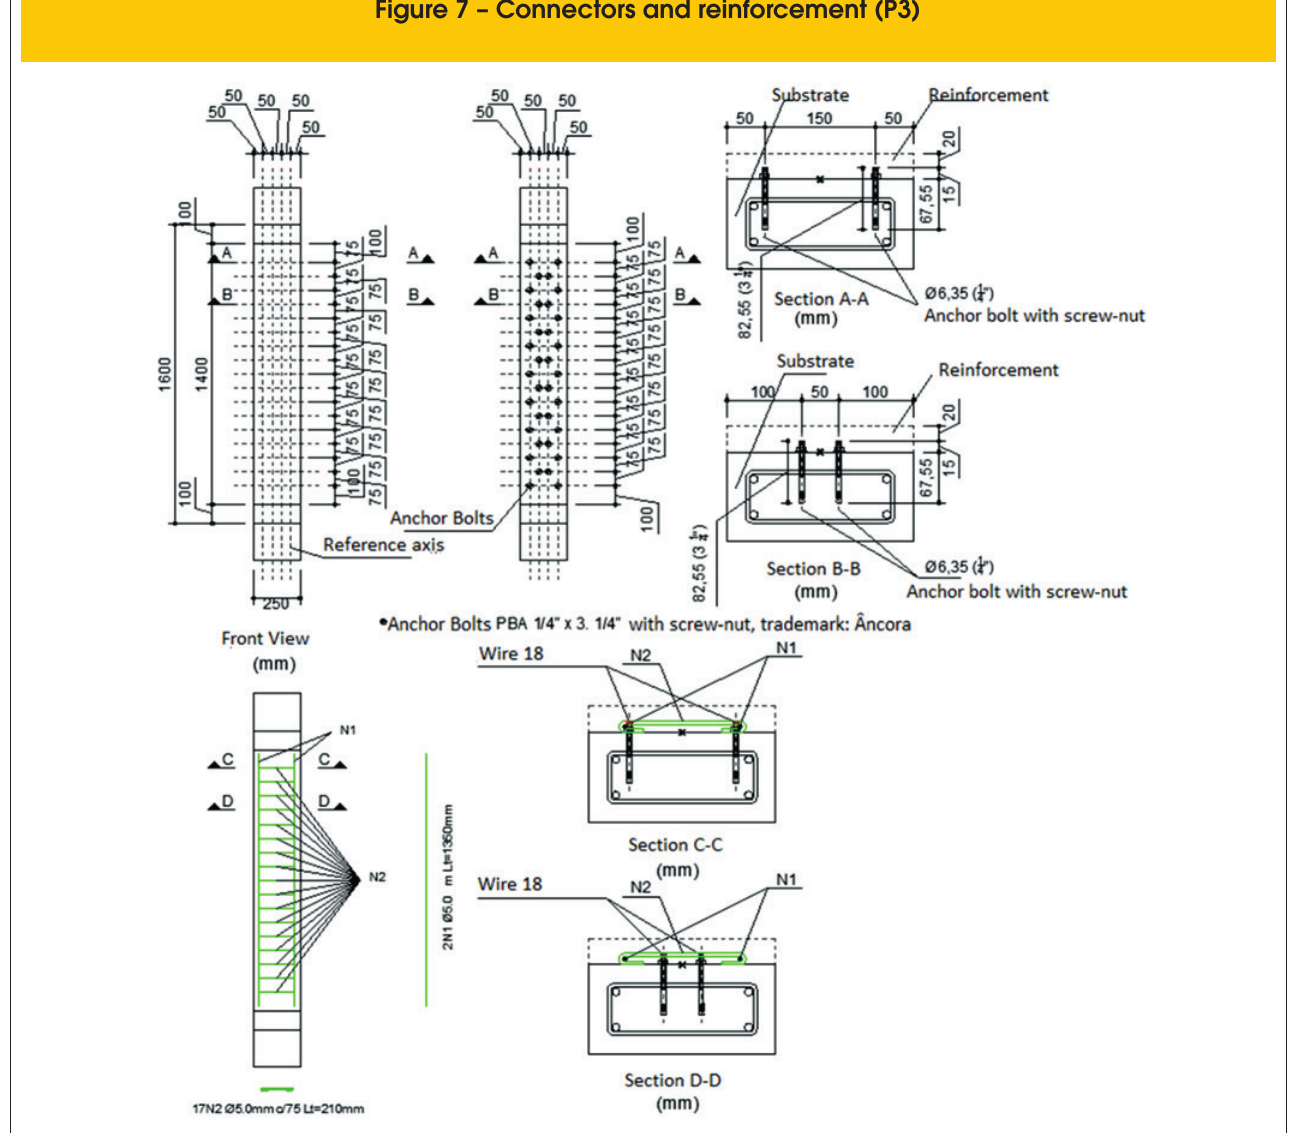
Figure 7 – Connectors and reinforcement